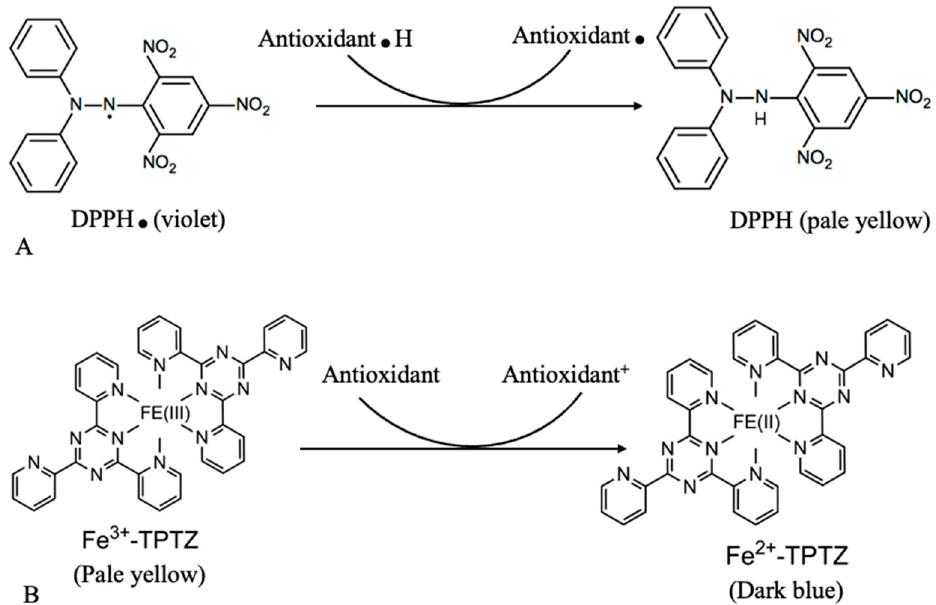
Figure 1. Reaction underlying the ( A ) DPPH (2,2-diphenyl-1-picrylhydrazyl) and ( B ) FRAP (ferric